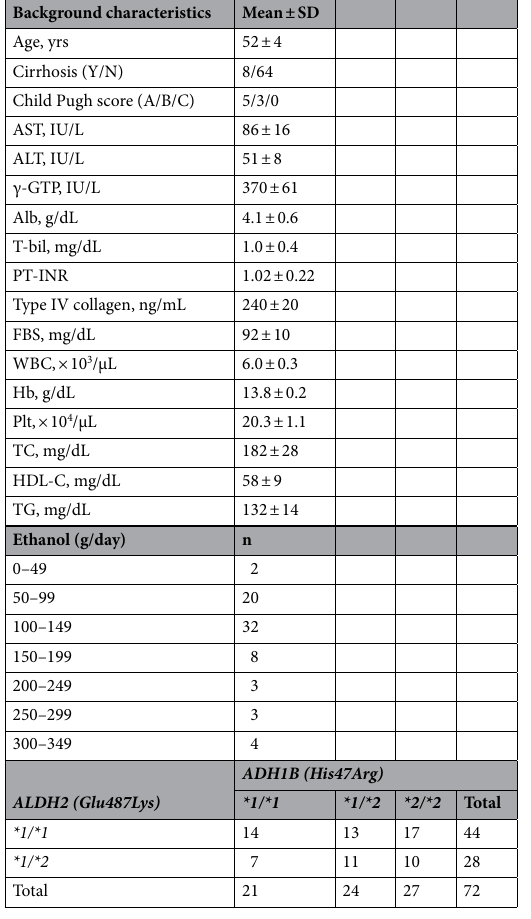
Table 1. Characteristics of patients with alcohol